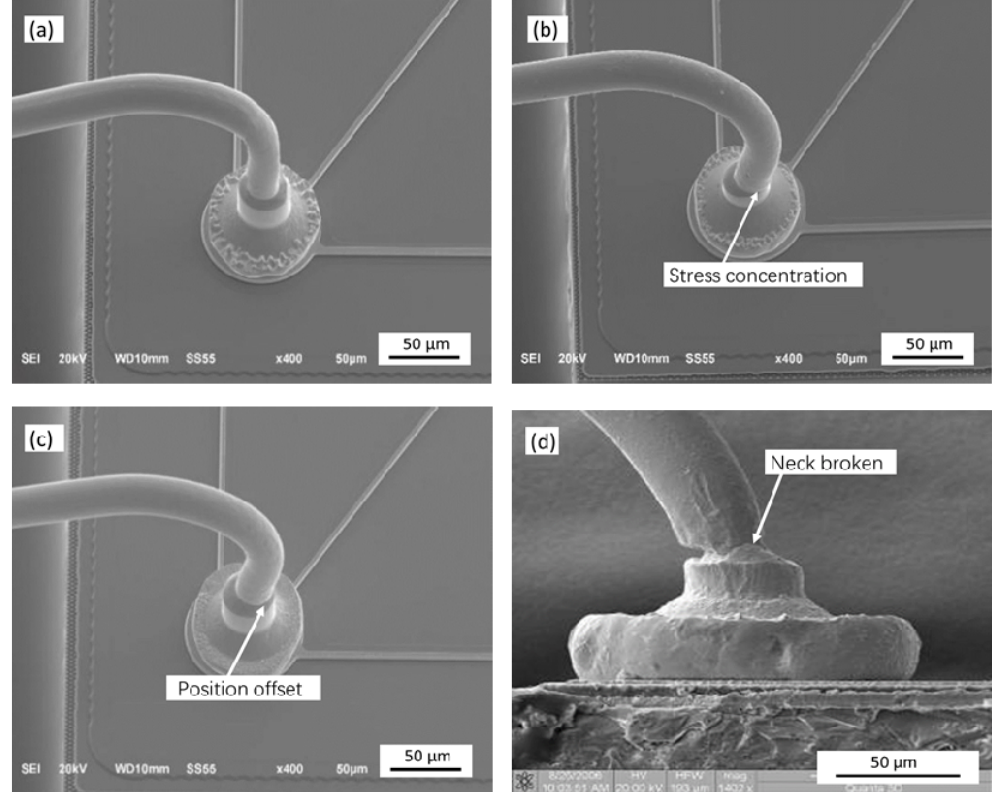
Figure 5. The morphology of the ball bonded points with the IHDs of: ( a ) 33 μ m; ( b ) 26 μ m; ( c ) 41 μ m; ( d ) the neck fracture of the ball bonded point caused by the small IHD of the capillary.